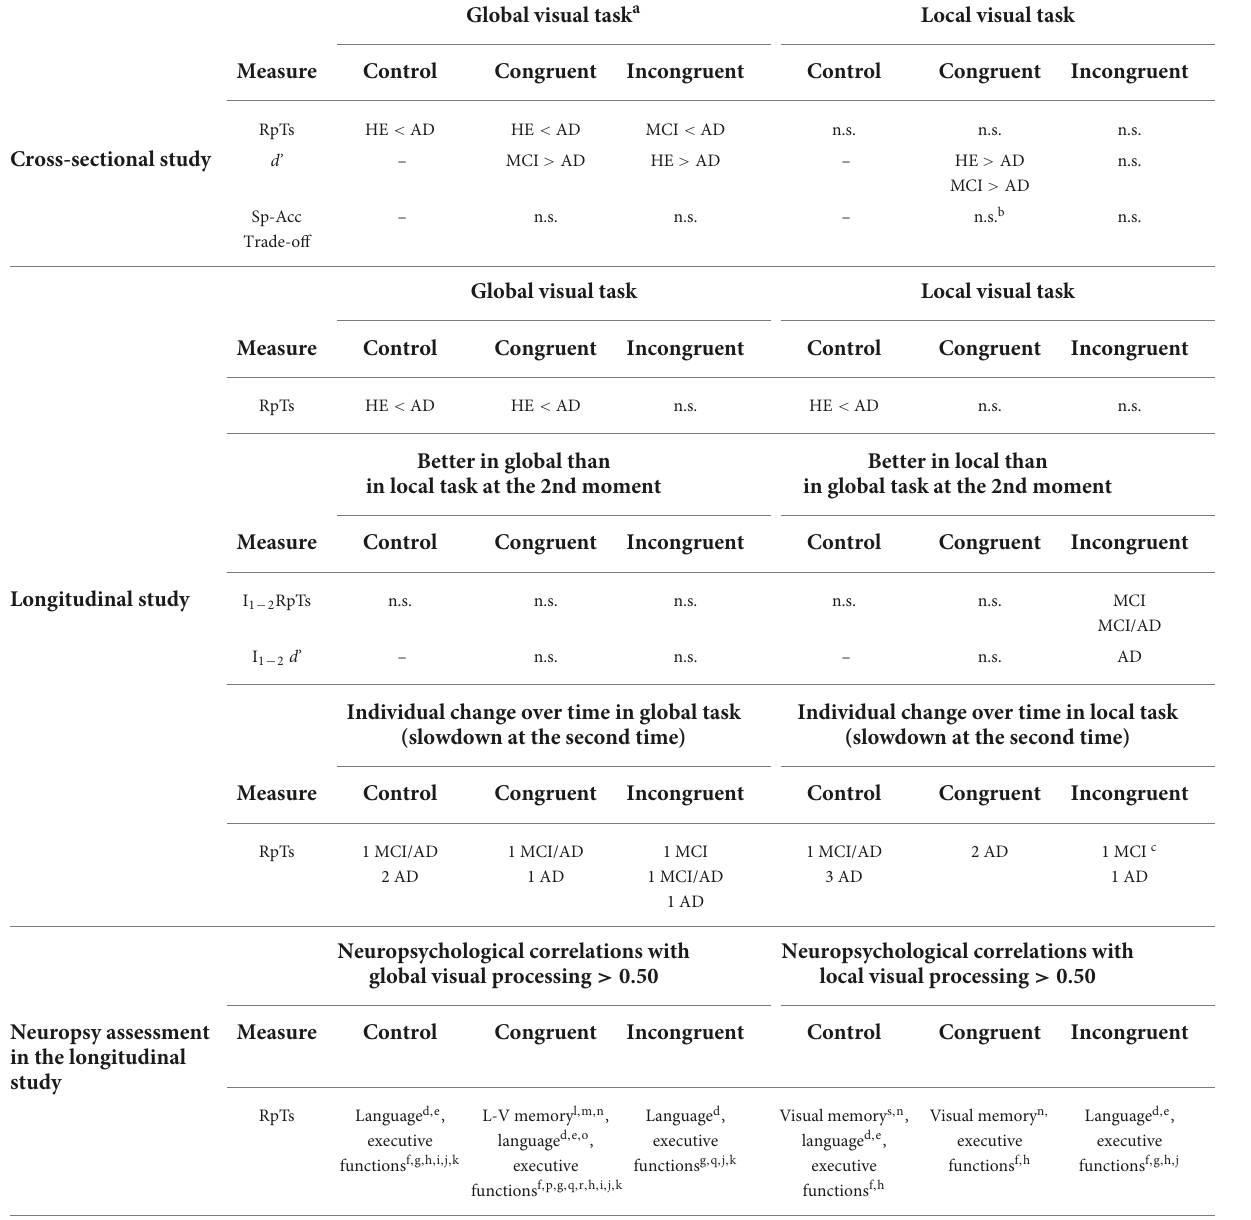
TABLE 7 Summary of the main findings found in both the cross-sectional and longitudinal